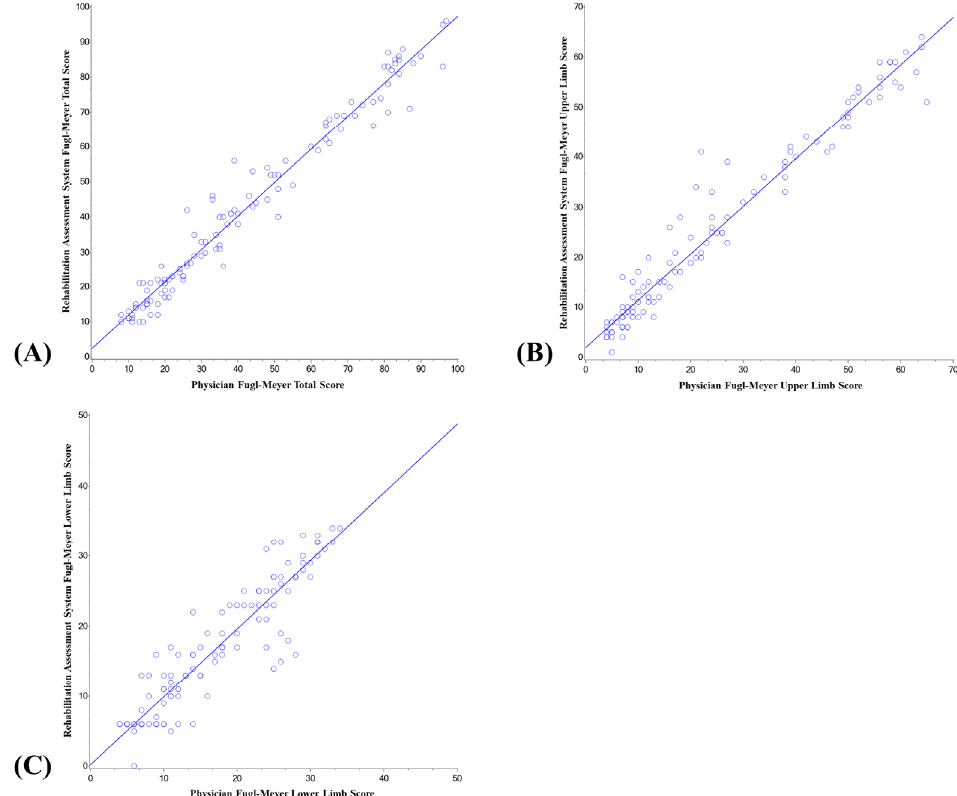
Figure 5. Intelligent rehabilitation system score and physician’s FMA score regression analysis chart. Total score ( A ), upper-limb score ( B ), and lower-limb score ( C ) are the regression analysis results of the intelligent rehabilitation assessment system score and the physician’s FMA score.